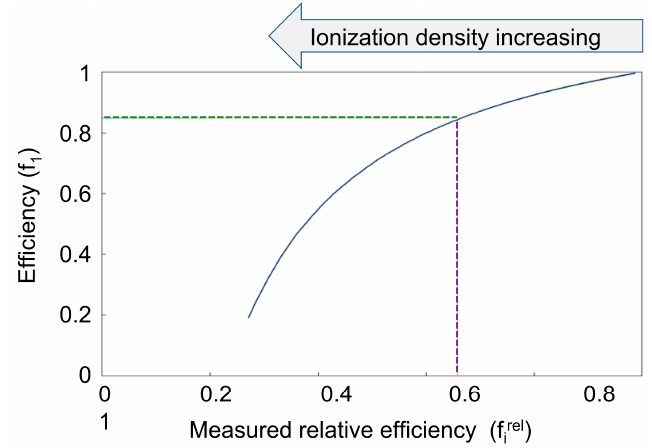
Figure 3. Example of chamber efficiency ( f 1 ) as a function of the relative counts per unit of thickness measured by a multi-gap detector ( f (cid:2919)(cid:2928)(cid:2915)(cid:2922) = Q (cid:2919)(cid:4593) d 1 / Q (cid:2869)(cid:4593) d j ).